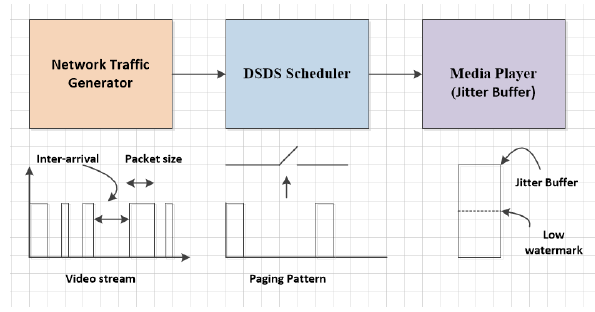
Figure 3 . Simulation